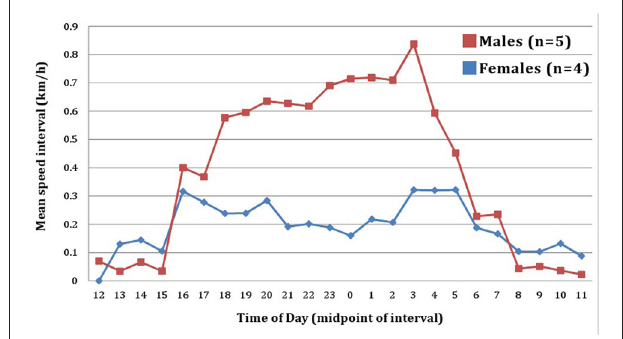
FIGURE 5 | Mean movement speed of lions by hour of day. Speed was inferred by measuring displacement between successive GPS fixes, adjusted to hourly